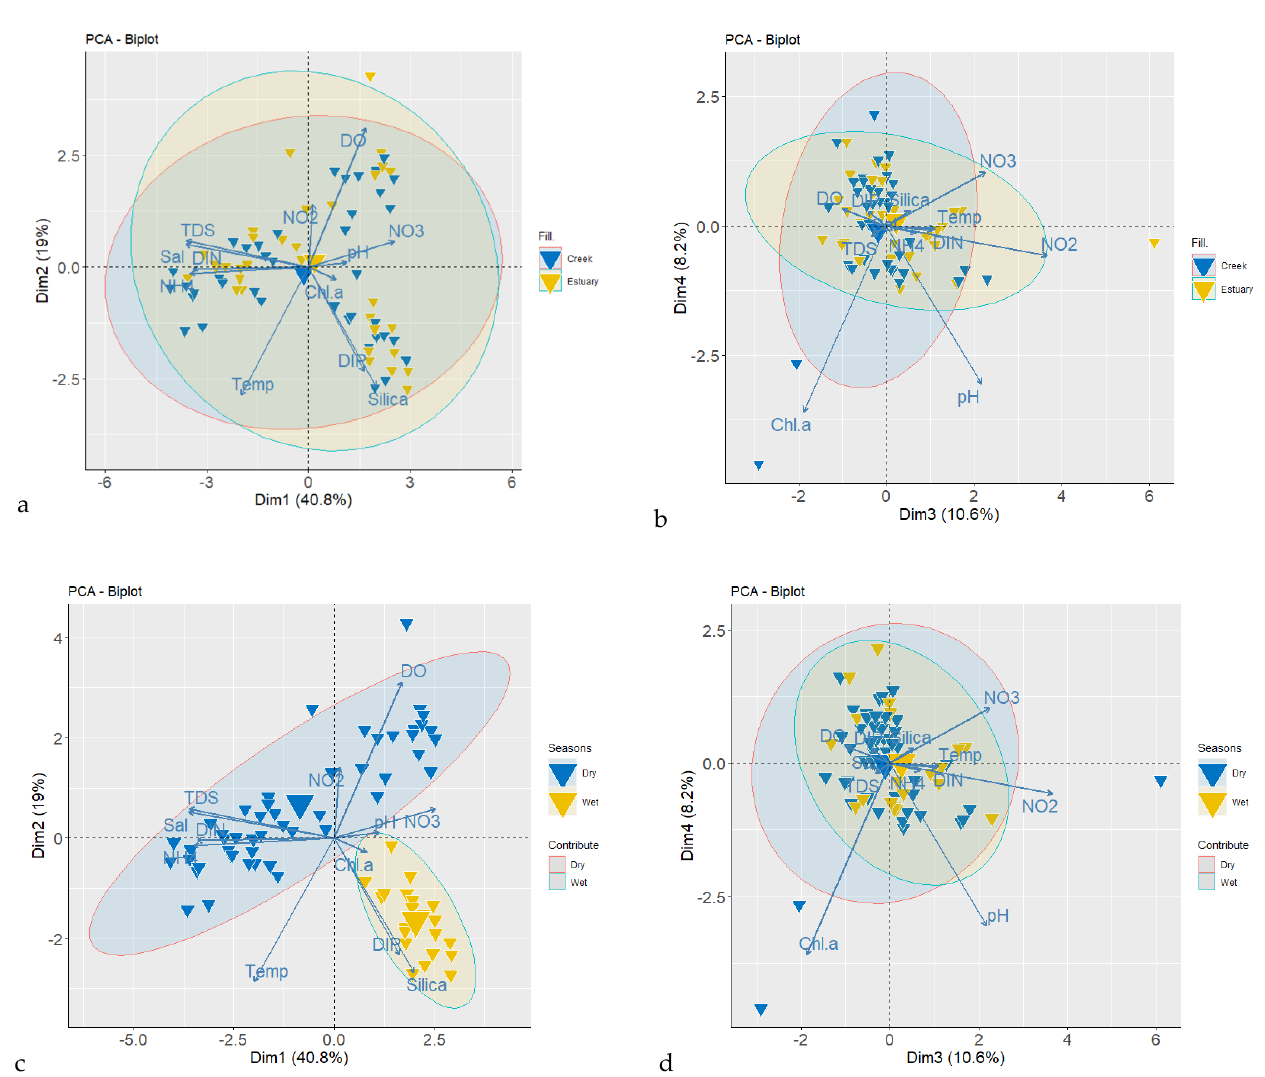
Figure 6. Biplot of the principal component analysis (PCA) of different environmental parameter distributions in the tidal mangrove creeks and the PRE. ( a ) PCA biplot for the first and second axes between the creek and estuary, ( b ) PCA biplot for the third and fourth axes between the creek and estuary, ( c ) PCA biplot for the first and second axes between the dry and wet seasons, ( d ) PCA biplot for the third and fourth axes between the dry and wet seasons.